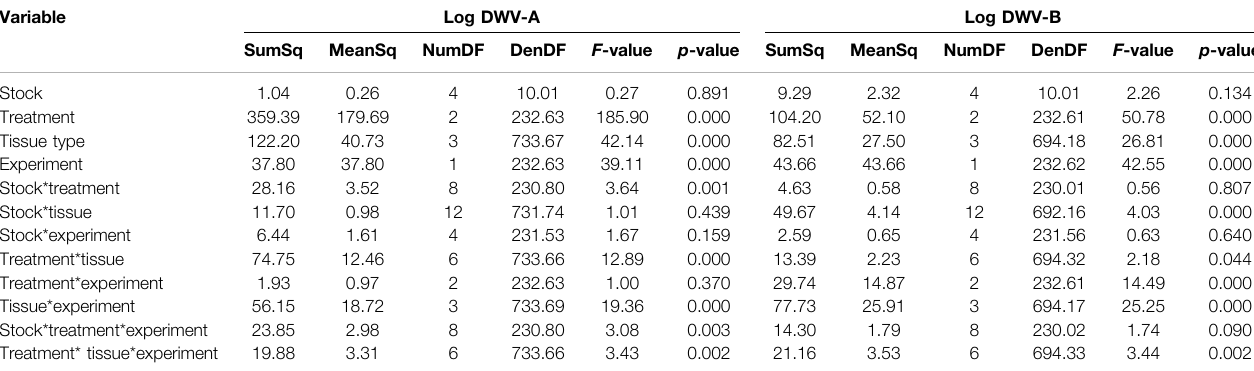
TABLE 3 | Day 7 comparison ANOVAs. ANOVA summaries for log DWV-A and DWV-B linear mixed models analyzing day 7 values for pupal and adult-injected bees (experiment). For pupal injections, the mite treatment was excluded; all other treatments remained in the analysis (control, PBS injection, and sublethal DWV injection). Each experiment was conducted on the same three colonies of each of the fi ve stocks with the same four tissue types analyzed.